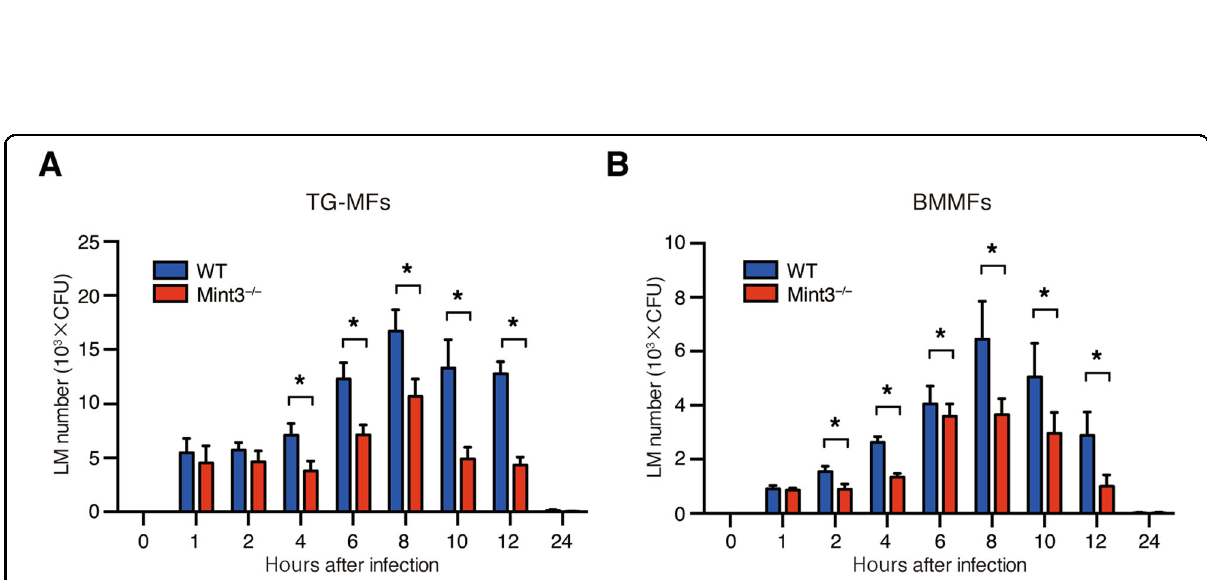
Fig. 2 Mint3 de fi ciency attenuates LM growth within macrophages. A Thioglycolate-induced peritoneal macrophages (TG-MFs) and B bone marrow-derived macrophages (BMMFs) from WT or Mint3 – / – mice were infected in vitro with 10 5 CFUs of LM (MOI = 1). The bacterial burden was determined 1, 2, 4, 6, 8, 10, 12, and 24 h after infection. Data are presented as the means ± SDs of triplicates. Data are representative of two independent experiments. * P < 0.05 by the Student ’ s t -test.